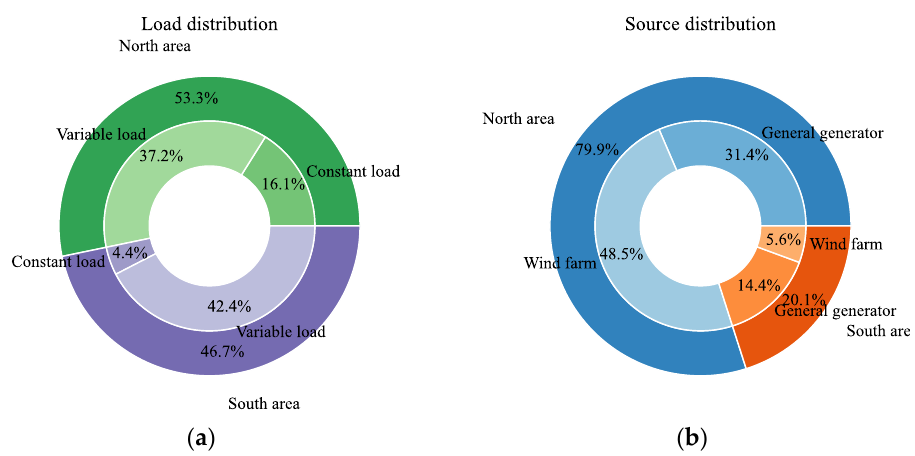
Figure 5. ( a ) The load distribution in the modified IEEE RTS-24 bus system. ( b ) The source distribu- tion in the modified IEEE RTS-24 bus system. Table 2. Changes of generator set and load in the modified IEEE RTS-24 bus system. Node